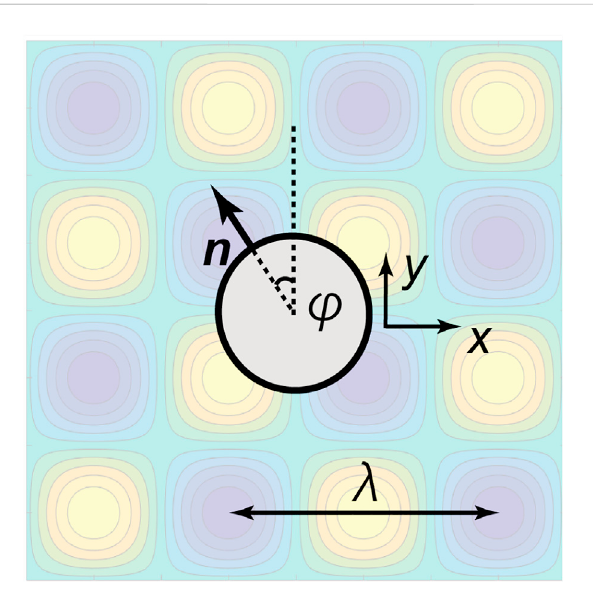
FIGURE 5 Bird ’ seyeviewofthesquirmerabovethedoublyperiodicsurface topography of Eq. 5, as depicted in Figure 2B, with λ = 4. The angle φ is de fi ned to be the angle of the x – y projection of the squirmer orientation vector n from the y -axis, as illustrated, and thus gives the direction of the squirmer in the x - y